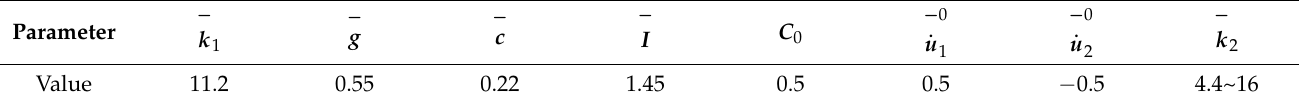
Table 2. Dimensionless